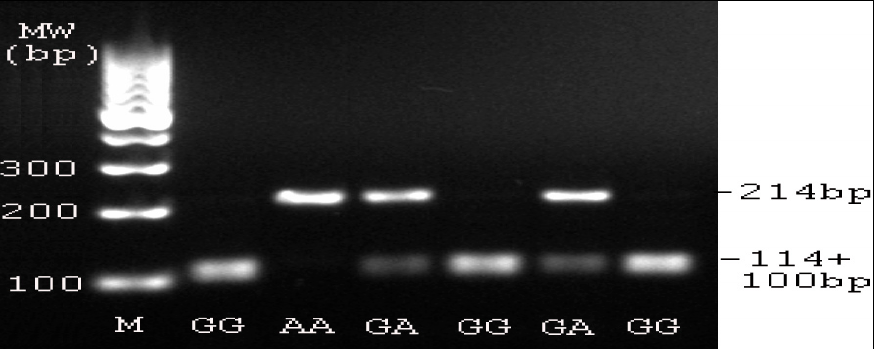
Figure 2. PCR- restriction fragment length polymorphism (PCR-RFLP) analysis for LOX G473A. Total DNA was extracted from the blood sample followed by PCR-amplification using the primers as shown in the text. The PCR product with 214 bp was treated with a specific restriction endonuclease Not I with the CG site targeting and analyzed on a 2% agarose gel, stained with ethidium bromide for visualization under ultraviolet light. After electrophoresis, homozygous G alleles which contain the CG site were recognized by DNA bands at 100 and 114 bp in length. An uncut fragment of 214 bp indicated the homozygous A alleles free of the CG site and the heterozygous GA genotype was displayed as a combination of 214, 100, and 114 bp bands. Due to 114 bp and 100 bp DNA being close in the MW, they were smeared as one band in the gel electrophoresis.